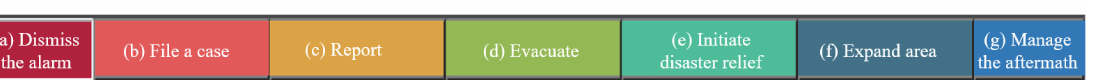
Figure 9. Disaster management: Standard operating procedures for response trigger. (Source: Research Data).